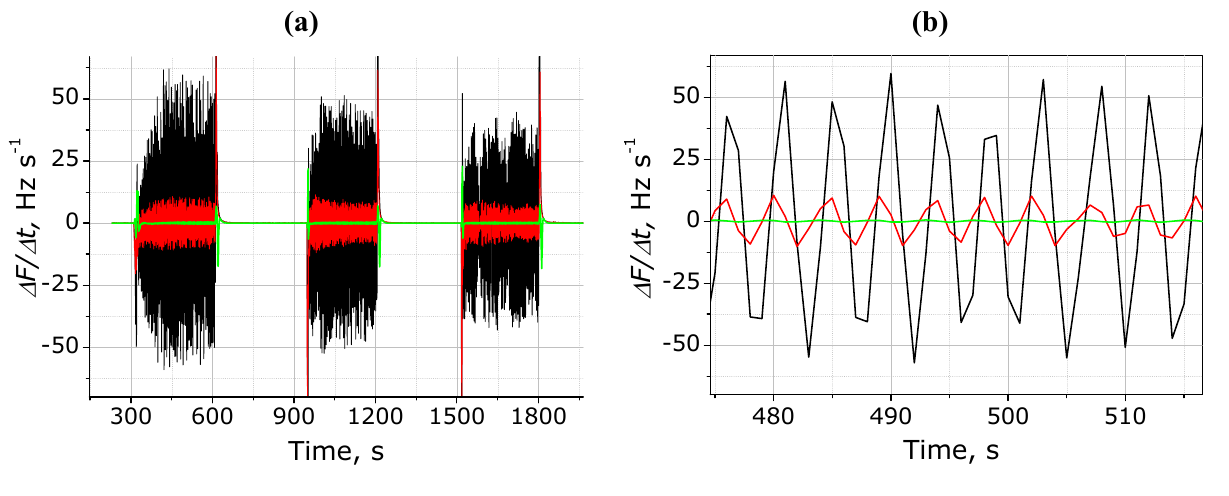
Figure 5. Differential representation of the sensor response used to track breathing movements: (a) three consecutive breathing episodes (black, (PDDA + /TSPP − ) (PDDA + /MnTSPP − ) ; green, blank); (b) enlarged presentation of the differentiated 15